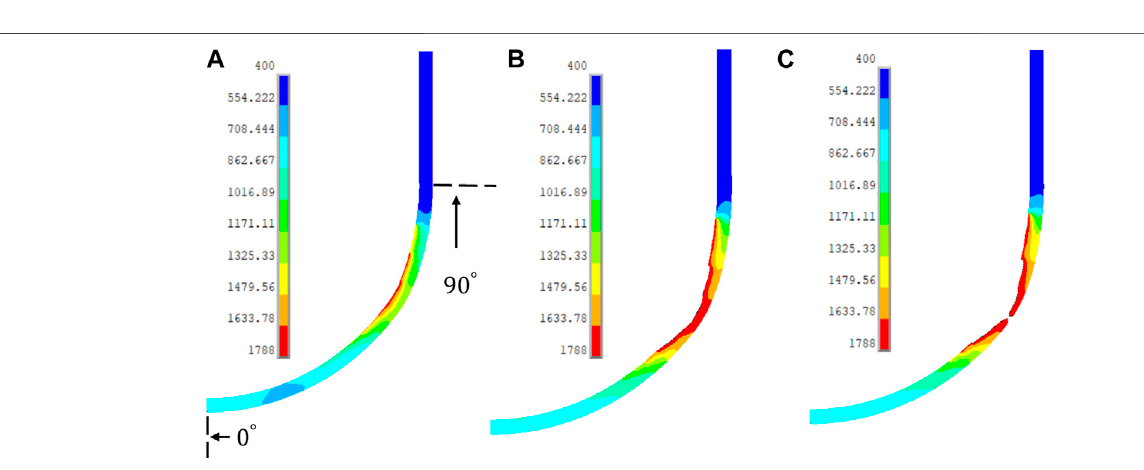
Frontiers in Energy Research |